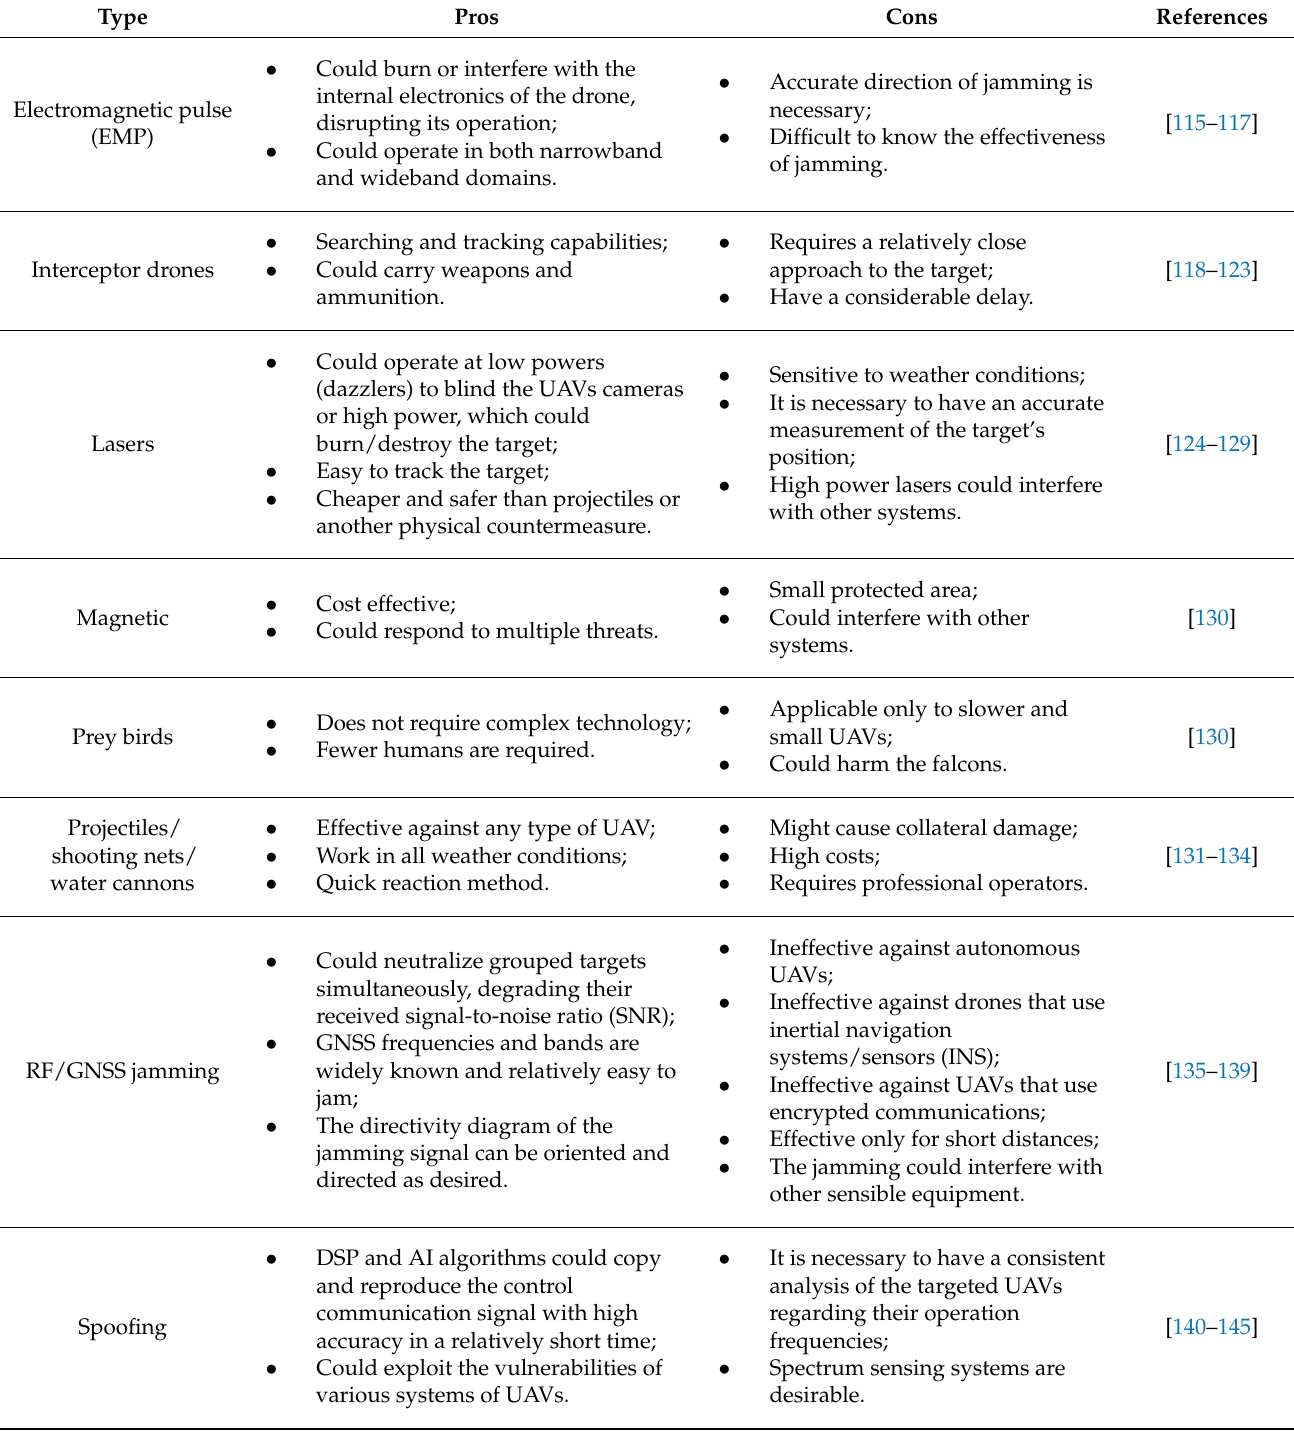
Table 6. Characteristics and limitations of countermeasure